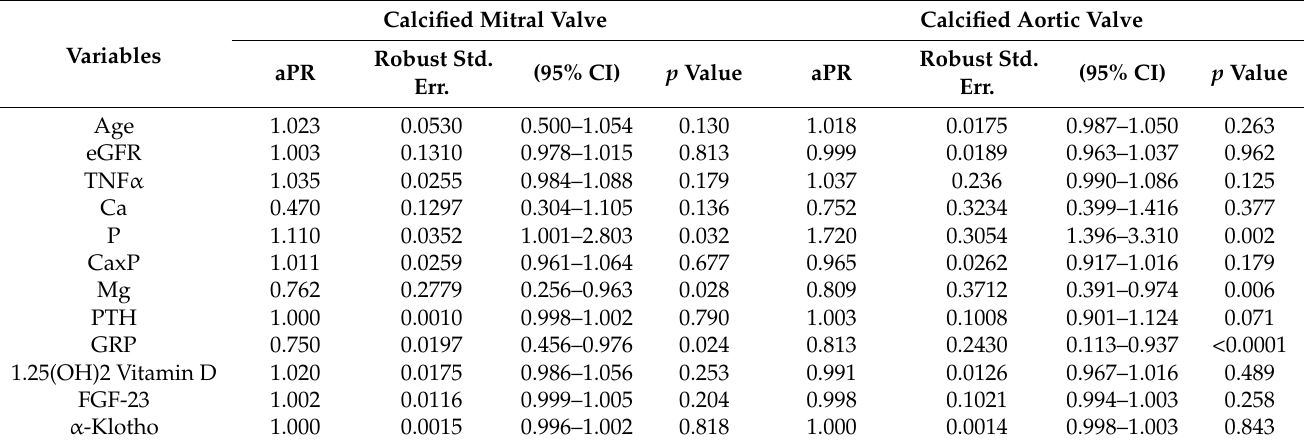
Table 6. GRP, Mg and P are cumulative risk factors for valvular calcifications.